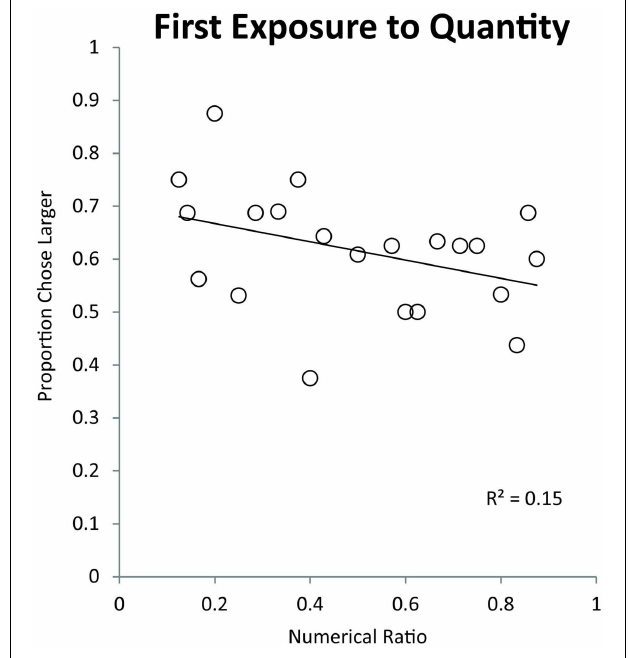
FIGURE 4 | Effect of numerical ratio on monkeys’ accuracy during their first exposure to numerical discrimination .The numerical ratio is the smaller number in a given pair divided by the larger number. Each data point represents a different number pair.The trend line represents a linear trend of decreasing accuracy with finer numerical